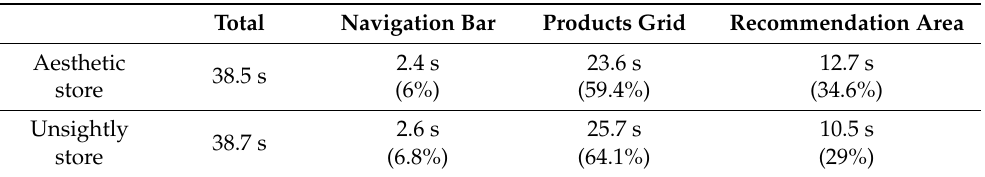
Table 1. Average fixation time users observed the given AOIs. This time is presented in parentheses as a percentage of the average total fixation time by all